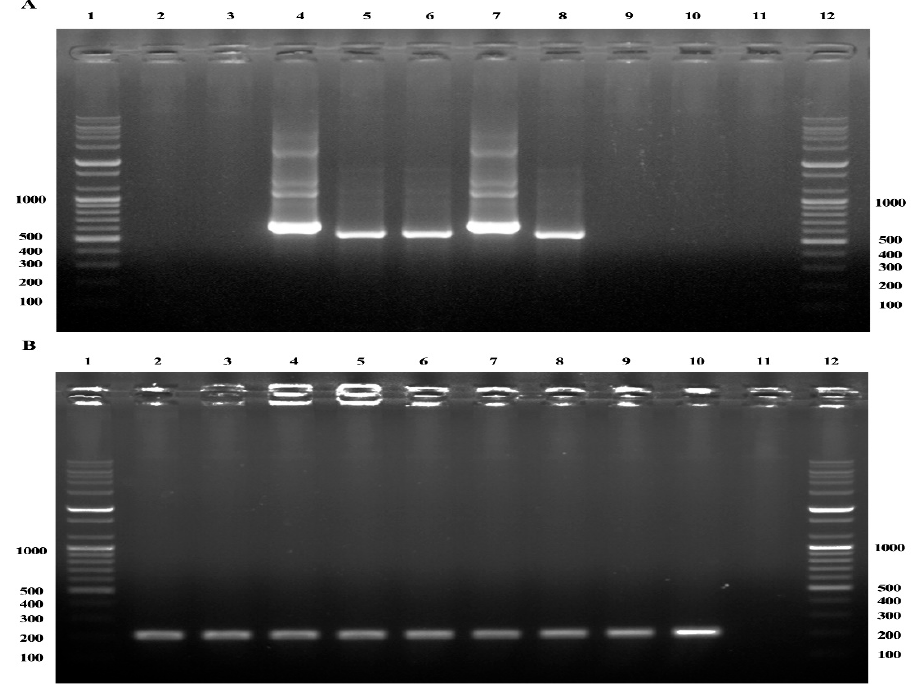
Figure 1. PCR detection of Anaplasma 16S rRNA and horse housekeeping gene (HKG) 18S rRNA in horse blood and lung tissue samples. ( A ) Nested PCR was used to identify the 16S rRNA genes of A. phagocytophilum and A. bovis using the primer sets EE1/EE2 and SSAP2f/SSAP2r and EE1/EE2 and AB1f/AB1r, respectively. Lanes 1 and 12: 100 bp ladder; lanes 2 and 3: horse blood and lung tissue samples negative for Anaplasma spp. using the primers EE1/EE2 and SSAP2f/SSAP2r or AB1f/AB1r, respectively; lane 4: A. phagocytophilum PCR product (641 bp) from horse lung sample; lane 5: A. bovis PCR product (551 bp) from horse blood samples; lane 6: A. bovis PCR product (551 bp) from horse lung tissue samples; lane 7: PCR product (641 bp) of A. phagocytophilum previously detected in a horse (positive control); lane 8: PCR product (551 bp) of A. bovis previously detected in a horse (positive control); lanes 9 and 10: internal negative control samples of Coxiella burnetii previously detected in a horse using the primer sets EE1/EE2 and SSAP2f/SSAP2r and EE1/EE2 and AB1f/AB1r, respectively; lane 11: lack of an amplicon from horse DNA generated using primers EE1/EE2 and SSAP2f/SSAP2r/AB1f/AB1r. ( B ) Single-round PCR detection using primers specific to horse HKG 18S rRNA. Lanes are in the same order as described in ( A ) but previously published primer sequences were used, producing expected amplicons of 204 bp